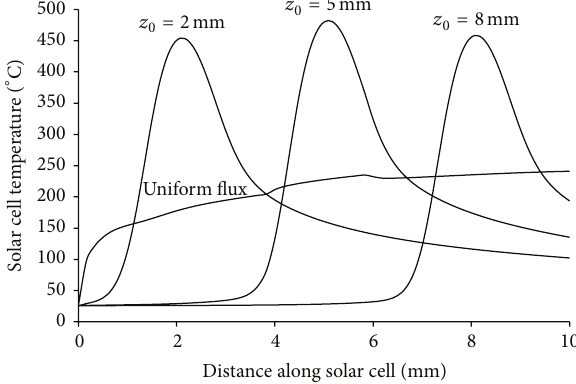
Figure 5: Variations in solar cell temperature obtained using different values of 𝑧 0 , when SD = 0.001, Re = 500, 𝜀 = 0.95 , and 𝐶 = 100